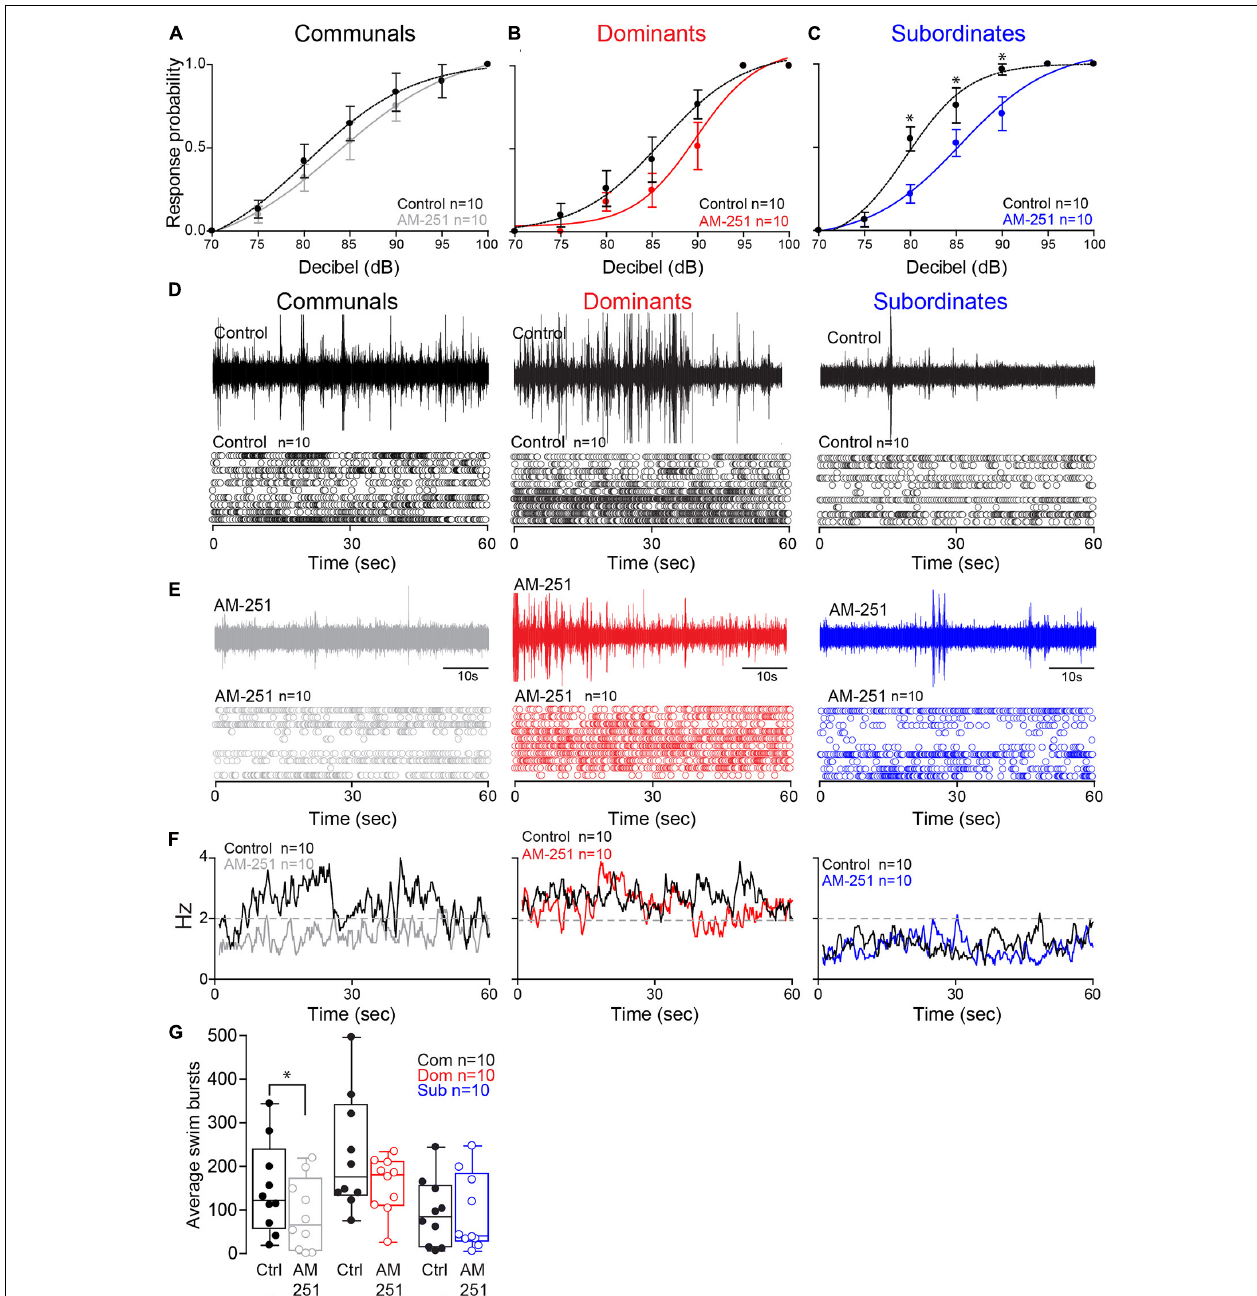
FIGURE 4 | Effect of AM-251 on status-dependent escape probability and swim frequency. (A–C) Probability of startle escape response before (control) and after AM-251 injections for communals, dominants and subordinates, respectively. Asterisks (* p < 0.05) denote statistical difference between control and experimental condition at the specified dB level. (D,E) 1 min recoding of far field-potentials of spontaneous swimming activity before (control) and after AM-251 injections for communal, dominants and subordinates, respectively, along with respective raster plots for all animals tested. (F) Average swimming frequency for all animals tested before and after AM-251 injection. (G) Box and whiskers plots of the average number of swim bursts per 1 min for each social phenotype. Box plot parameters are defined in Figure 3G